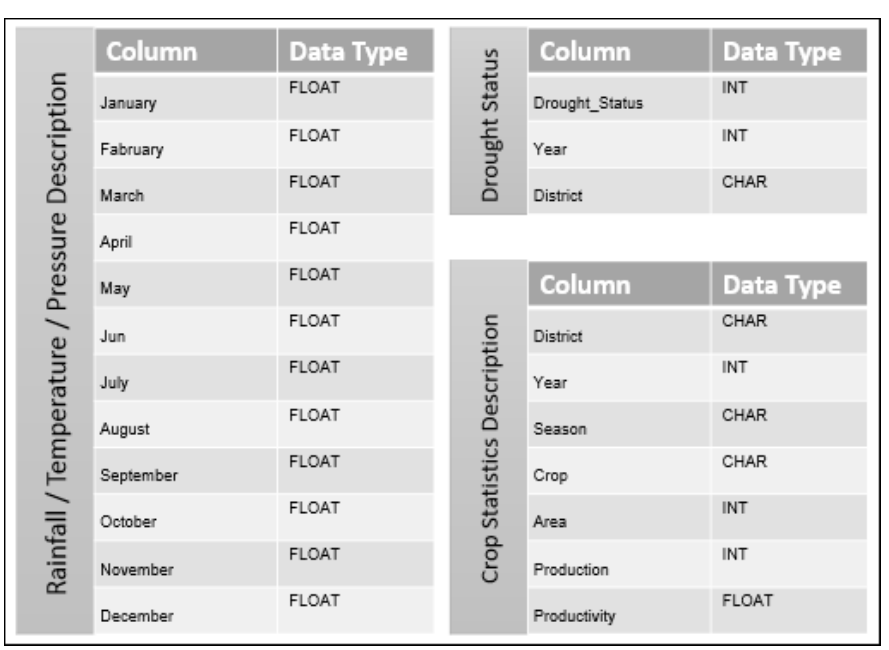
Figure 5. Raw format of rainfall, temperature, crop statistics, and drought status.